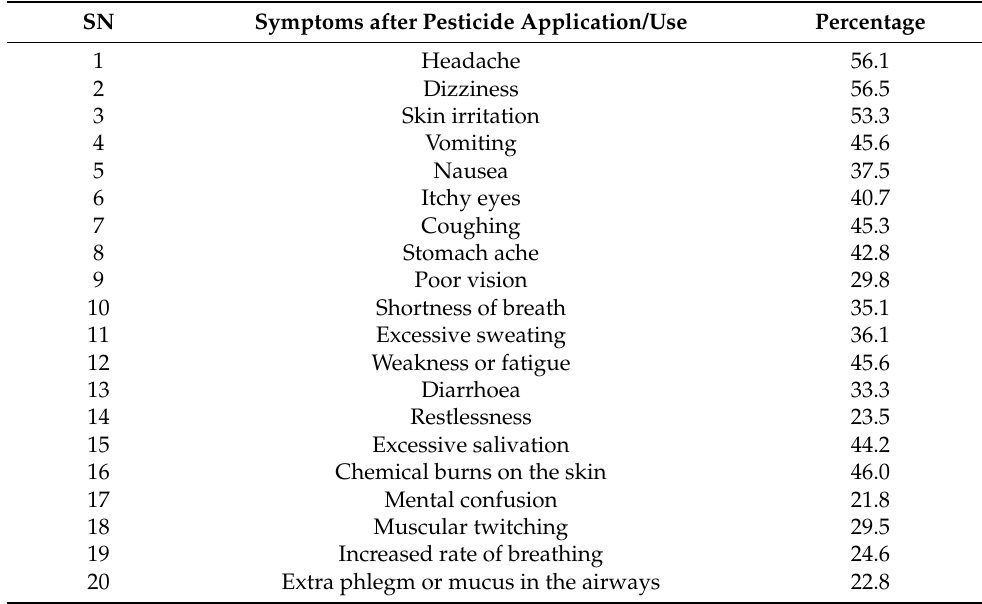
Table 4. Prevalence of Symptoms of Pesticide Intoxication among Farmers.